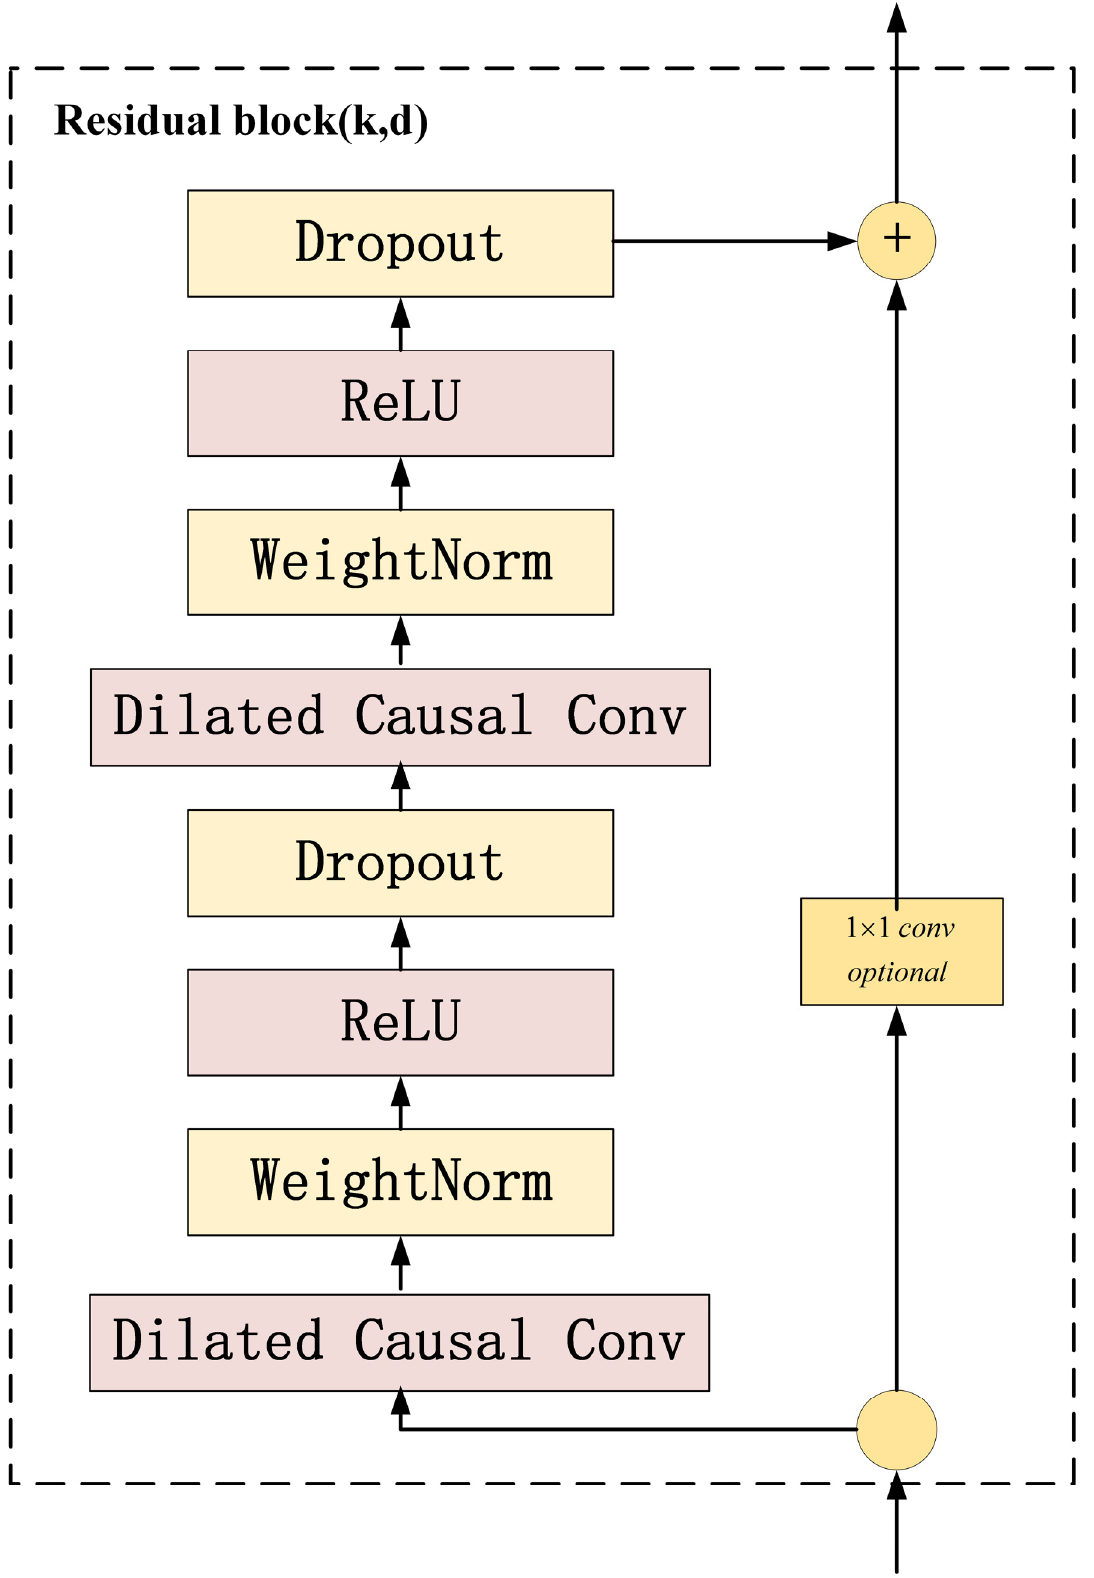
Figure 10. A residual block contains two layers of extended convolution and non-linear graphs, and WeightNorm and Dropout are also integrated with each layer to normalize the